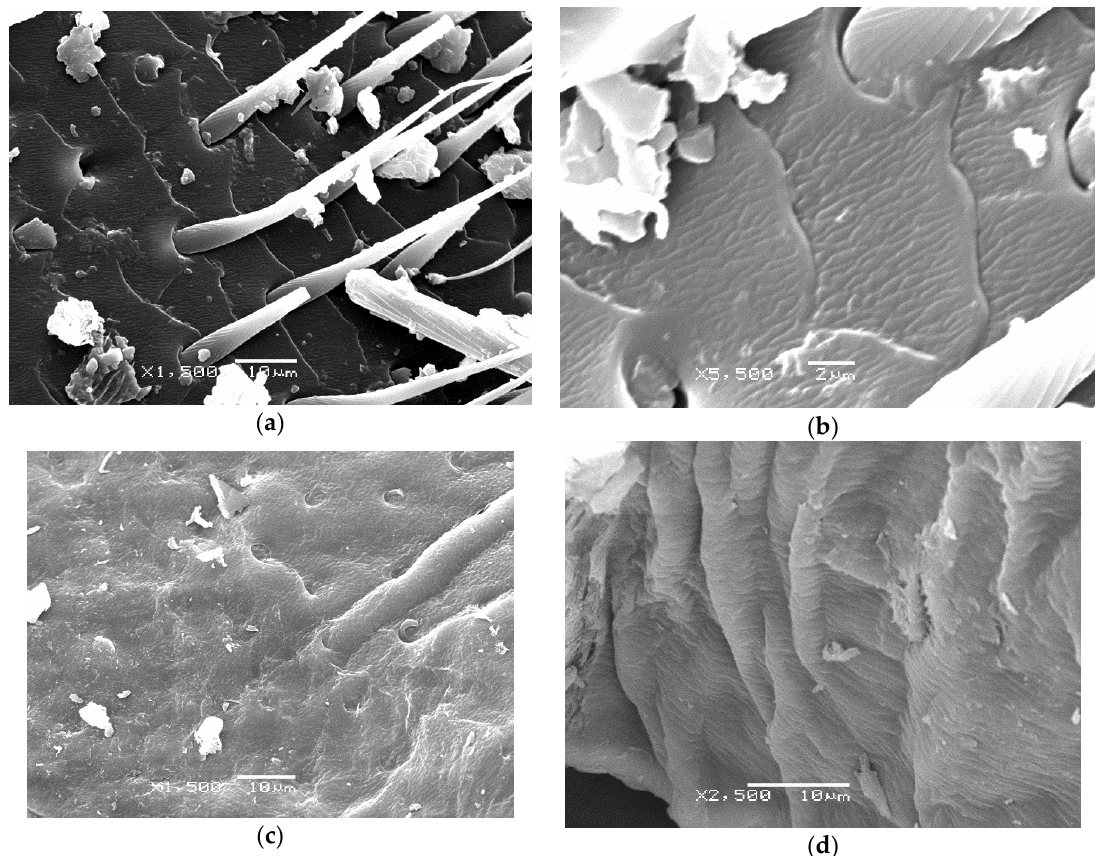
Figure 3. Scanning electron microscopy (SEM) pictures of chitin isolated from Vespa velutina . ( a ) magnification × 1500 (scale bar = 10 µ m); ( b ) magnification × 5500 (scale bar = 2 µ m); ( c ) magnification × 1500 (scale bar = 10 µ m) and ( d ) magnification × 2500 (scale bar = 10 µ m).